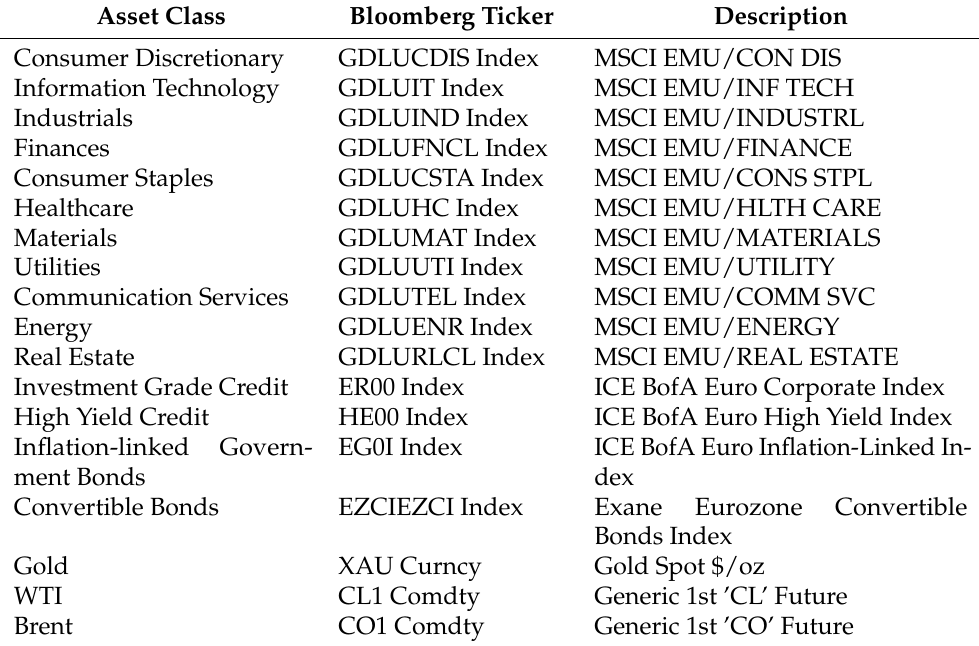
Table 3. Panel composition. The equity class is represented by several sector-based categories (finance, energy...), the fixed income class by four types of bonds (high yield, convertibles ...) and the commodity class by three different tangible assets (gold, WTI,